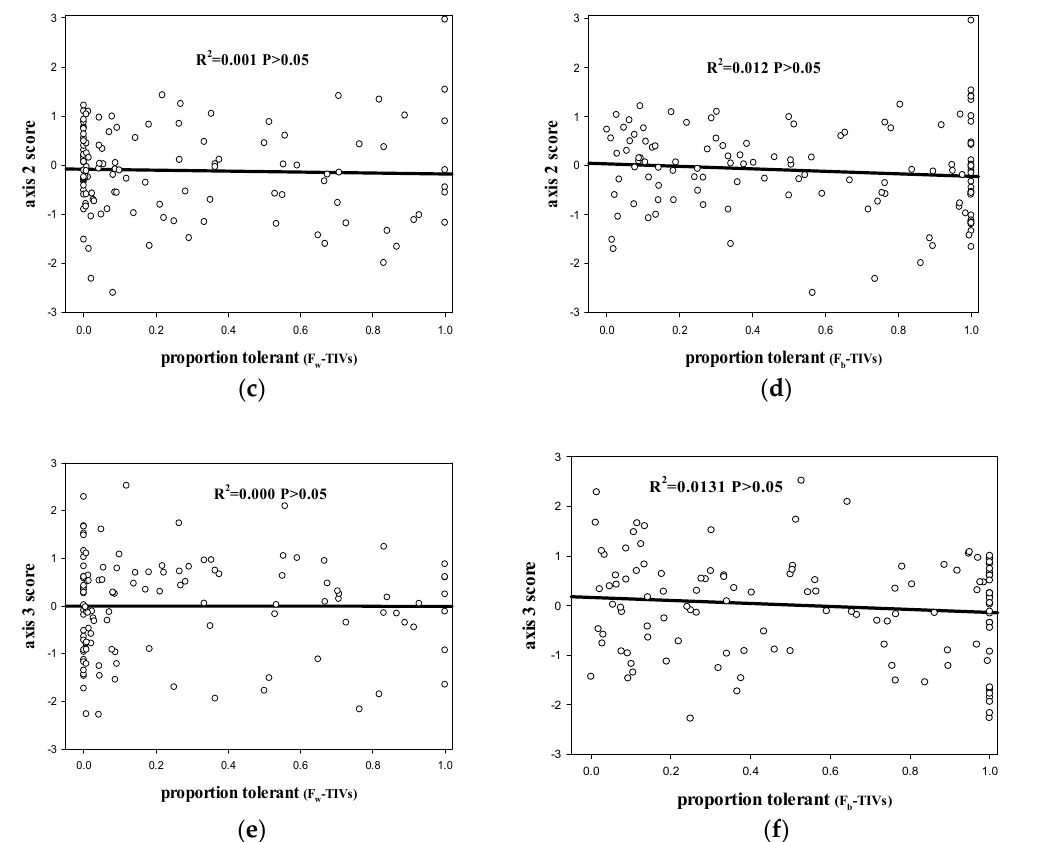
Figure 2. ( a ) scatterplot of PC1 site scores versus the proportion of tolerant fish at each site based on F W -TIVs; ( b ) scatterplot of PC1 site scores versus the proportion of tolerant fish at each site based on F b -TIVs; ( c ) scatterplot of PC2 site scores versus the proportion of tolerant fish at each site based on F W -TIVs; ( d ) scatterplot of PC2 site scores versus the proportion of tolerant fish at each site based on F b -TIVs; ( e ) scatterplot of PC3 site scores versus the proportion of tolerant fish at each site based on F W -TIVs; ( f ) scatterplot of PC3 site scores versus the proportion of tolerant fish at each site based on F b -TIVs. Line is best fit. (F b -TIVs: tolerance indicator values (TIVs) of fish based on biological traits approach. F W -TIVs: tolerance indicator values (TIVs) of fish based on weighted averaging (WA) method).